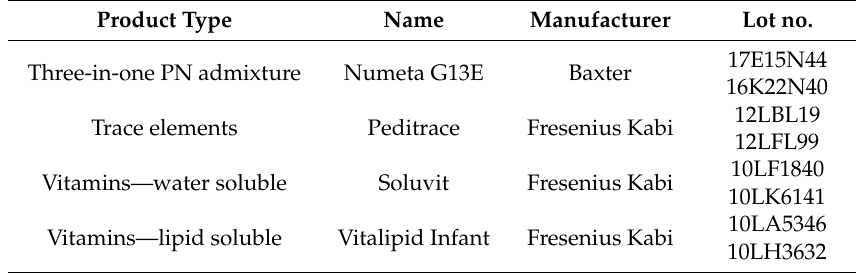
Table 1. Overview of Numeta G13E and additives.